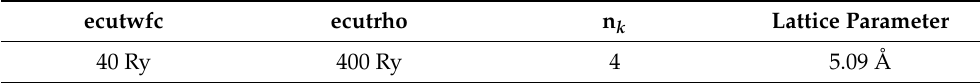
Table 1. Used parameters for all calculations. ecutwfc